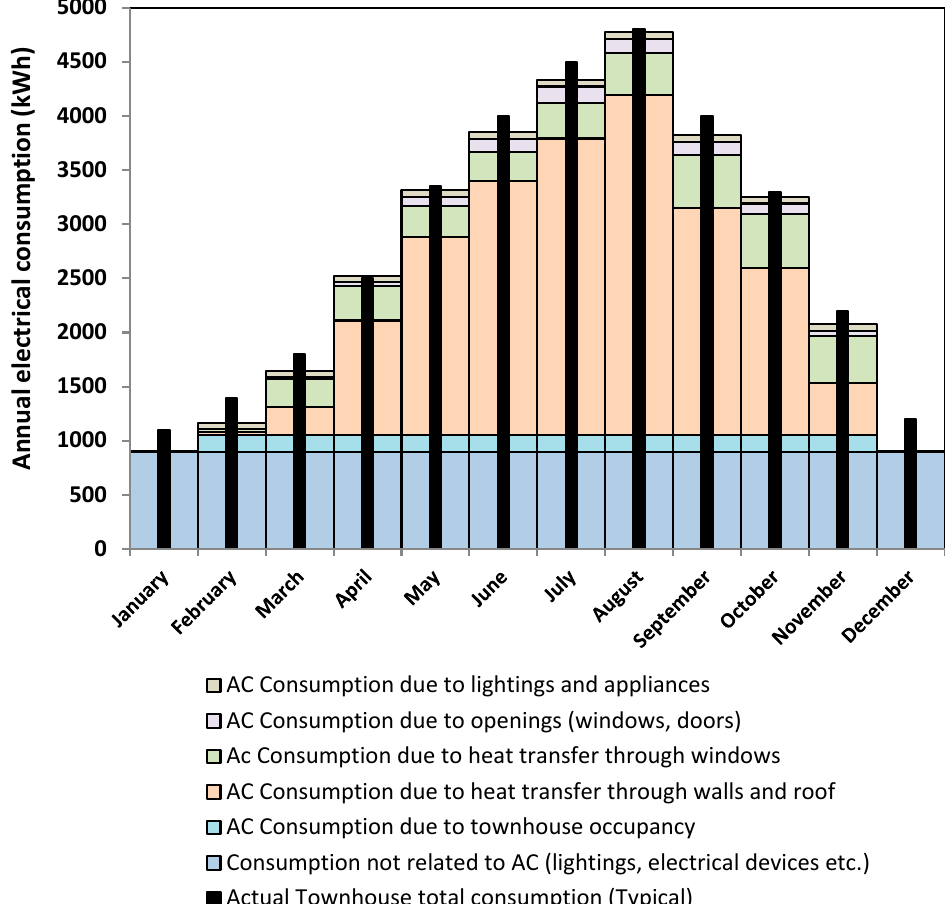
Figure 15. Annual electrical consumption profile of the townhouse without retrofitting.